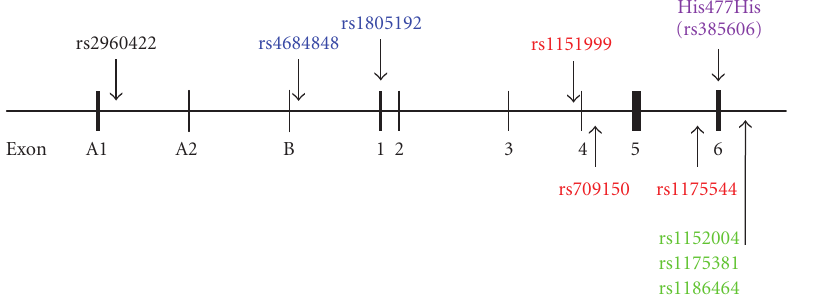
Figure 2: Physical location of the studied human PPARG polymorphisms. Several of these SNPs have been shown to be in high LD. All SNPs within an LD block are shown as the same color.